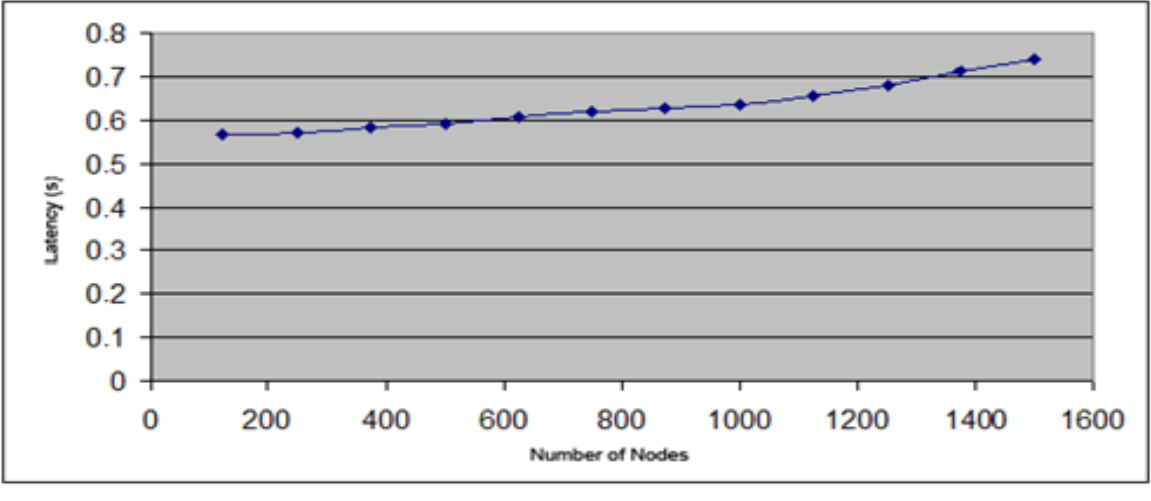
Figure 12. Latency in the IPv4 address assignment of a network from Class